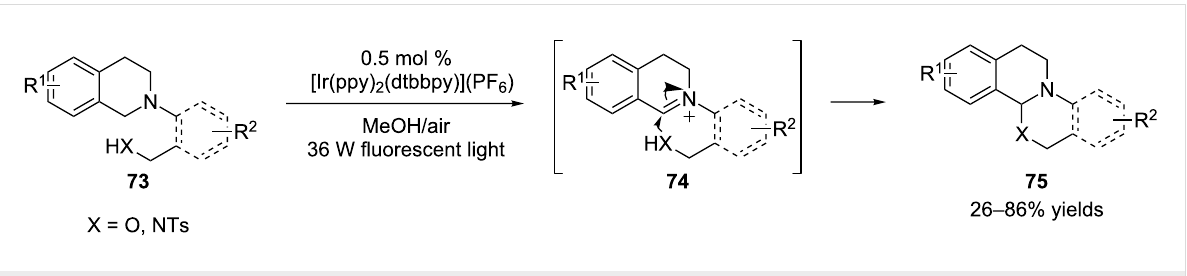
Scheme 19: Intramolecular interception of iminium ions by alcohols and sulfonamides.